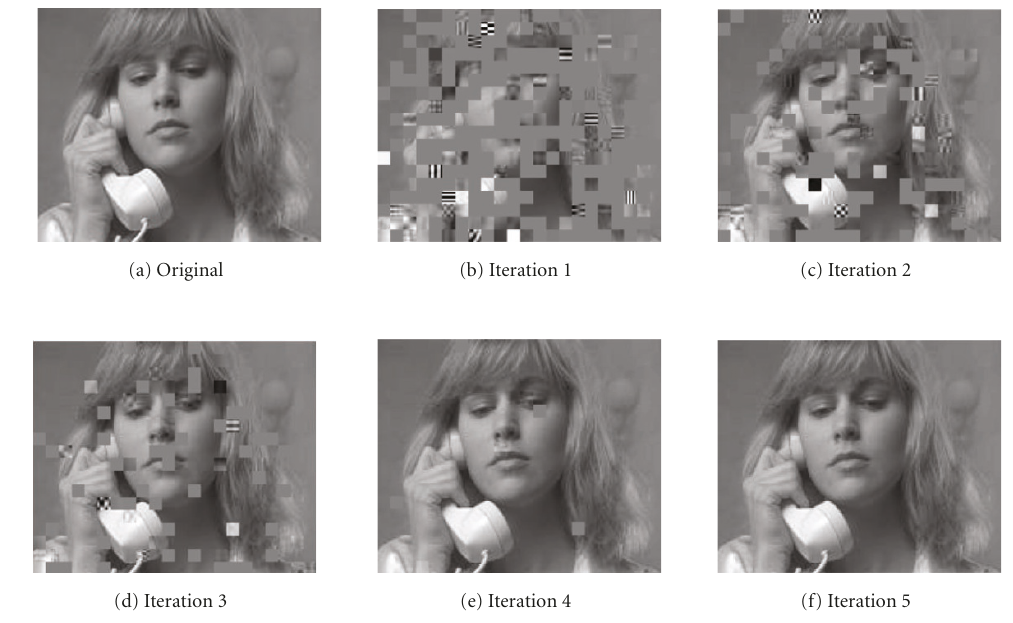
Figure 10: Original and decoded “Suzie” images over AWGN channel using typical turbo code with an E b /N 0 of 2dB.